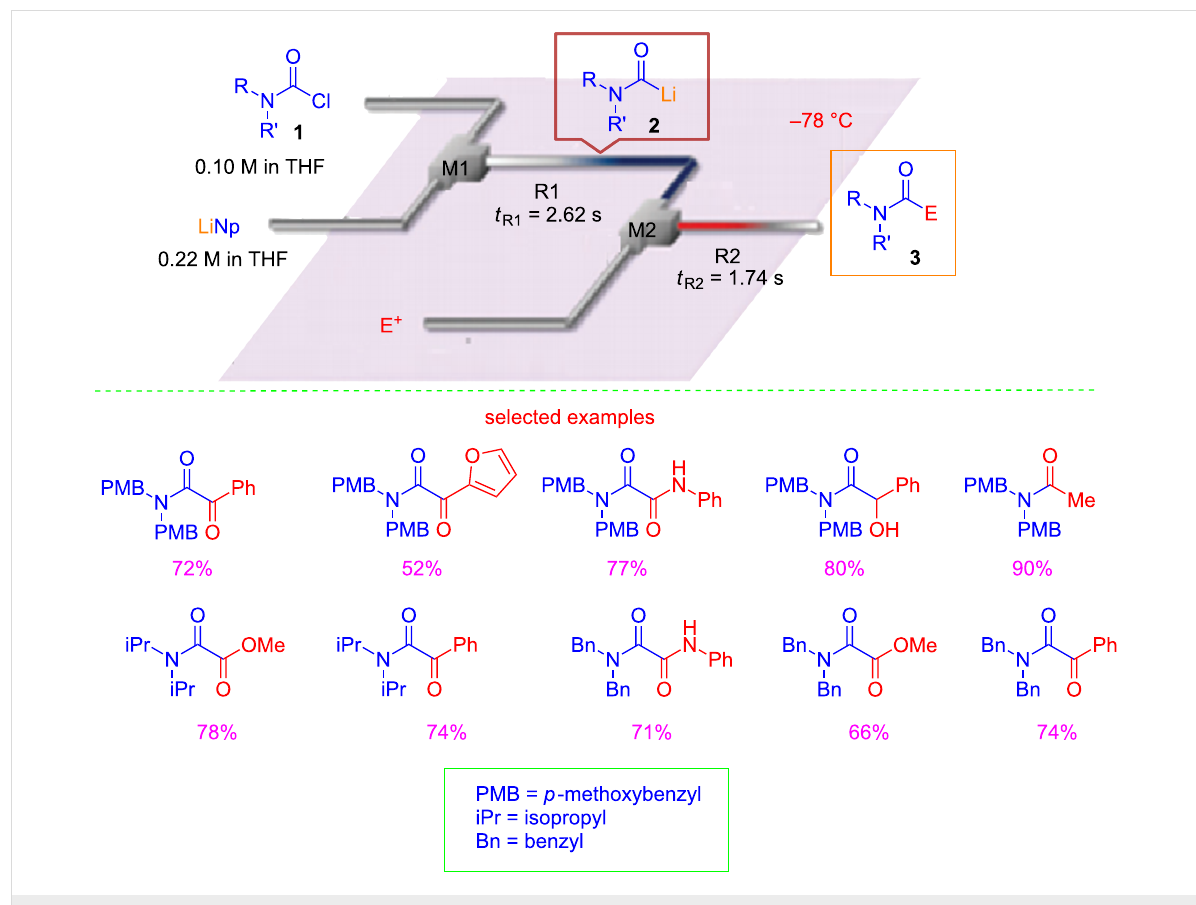
organolithium compounds bearing sensitive functional